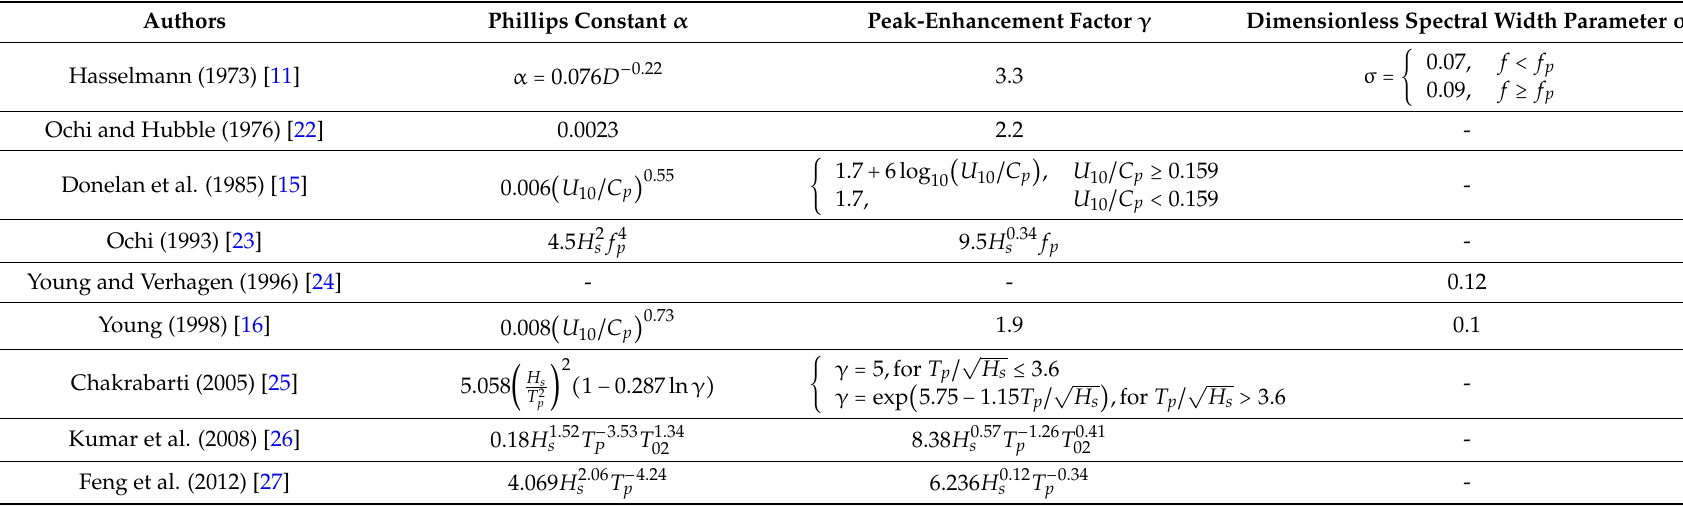
Table 1. Phillips constant, peak-enhancement factor and dimensionless spectral width parameter proposed in previous literatures. H s : significant wave height; F p : peak frequency; T 02 : zero-crossing mean wave period; C p : phase speed of components at the spectral peak frequency; D : non-dimensional